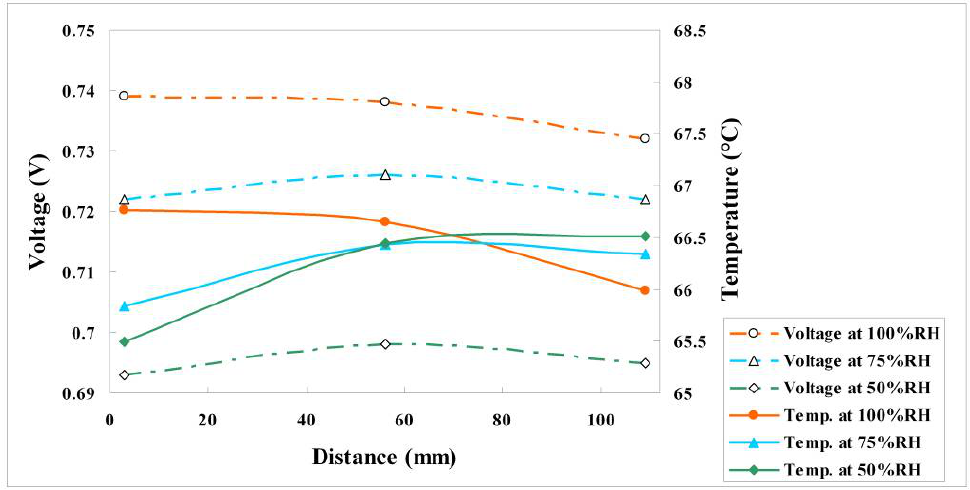
Figure 16. Variation of voltage and temperature at upstream, midstream and downstream (0.5 A/cm 2